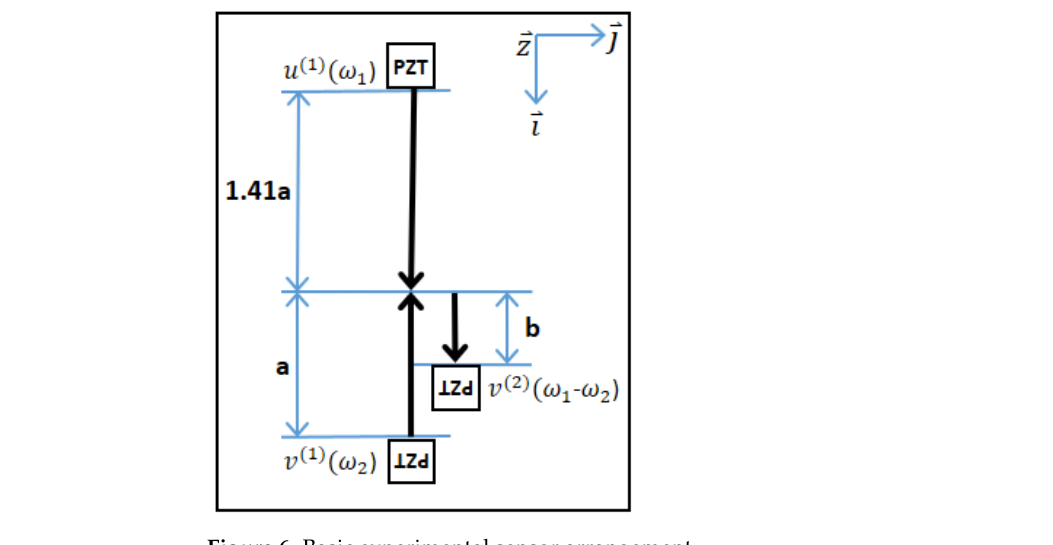
Figure 6. Basic experimental sensor arrangement.